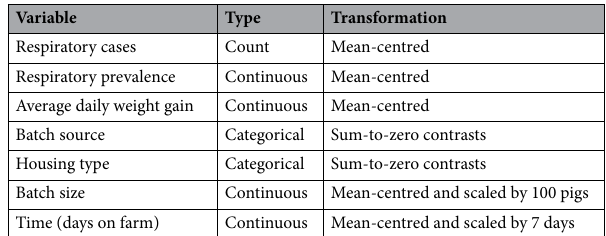
Table 2. Pig batch-level variables used in analyses and transformations for